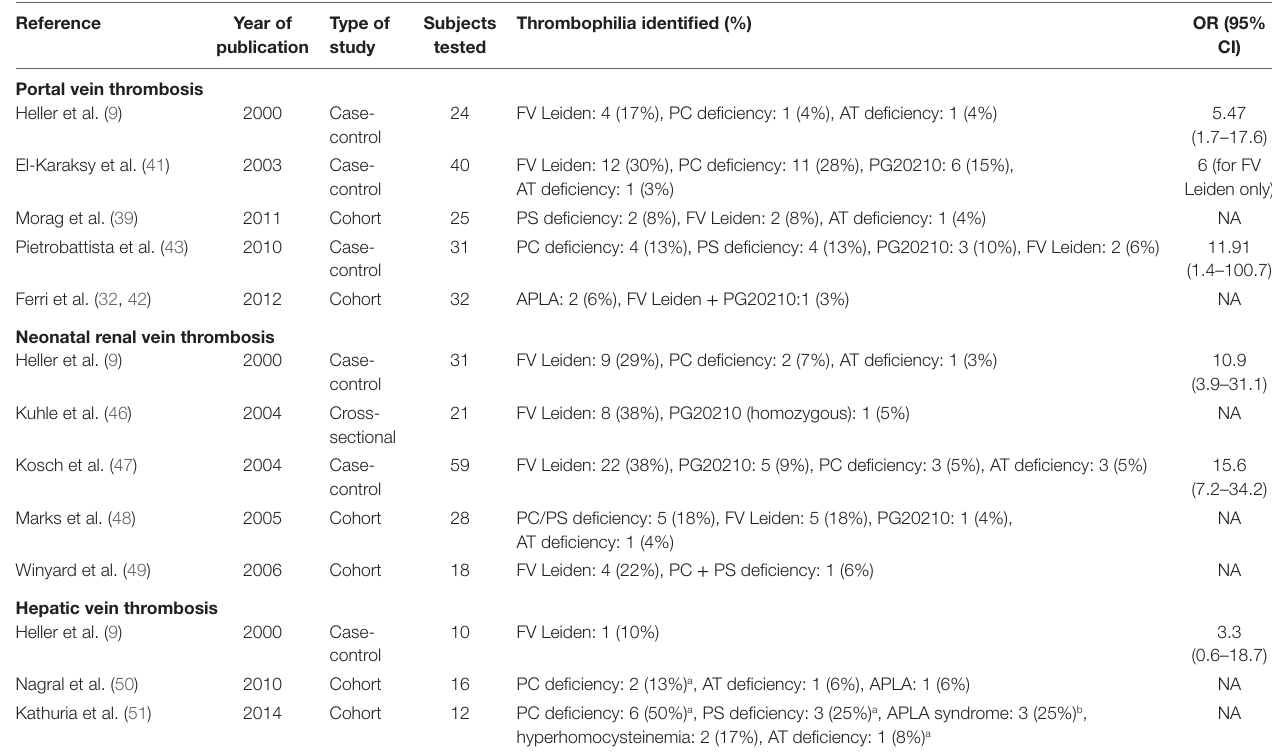
TABLe 1 | Studies investigating the association between thrombophilia and abdominal vein thrombosis.